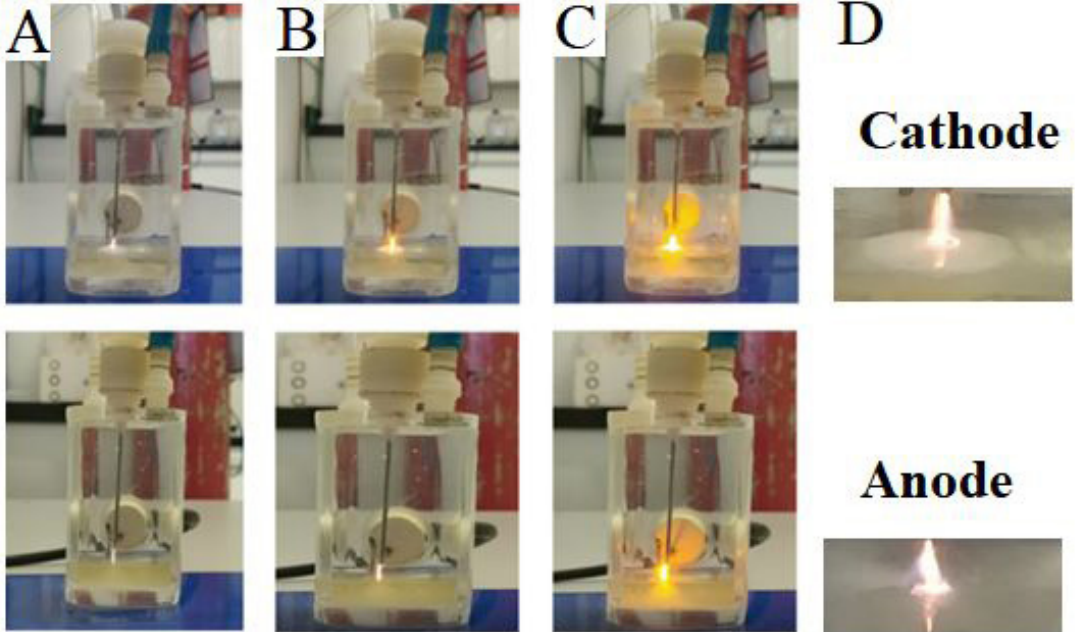
Figure 2. Different instants during plasma treatment. In the first moment plasma present pink color (A) and then starting to flicker (B), changing to yellow color (C). Details of crystal film formed in cathodic and turbidity in anodic configurations